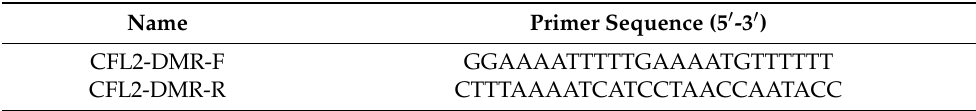
Table 4. Primer information of CFL2 DMR for